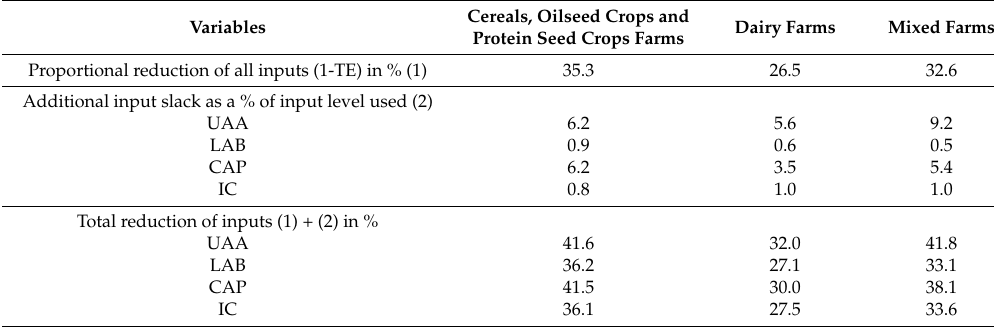
Table 7. Percentage of potential reduction of inputs under technology T1 (averages).